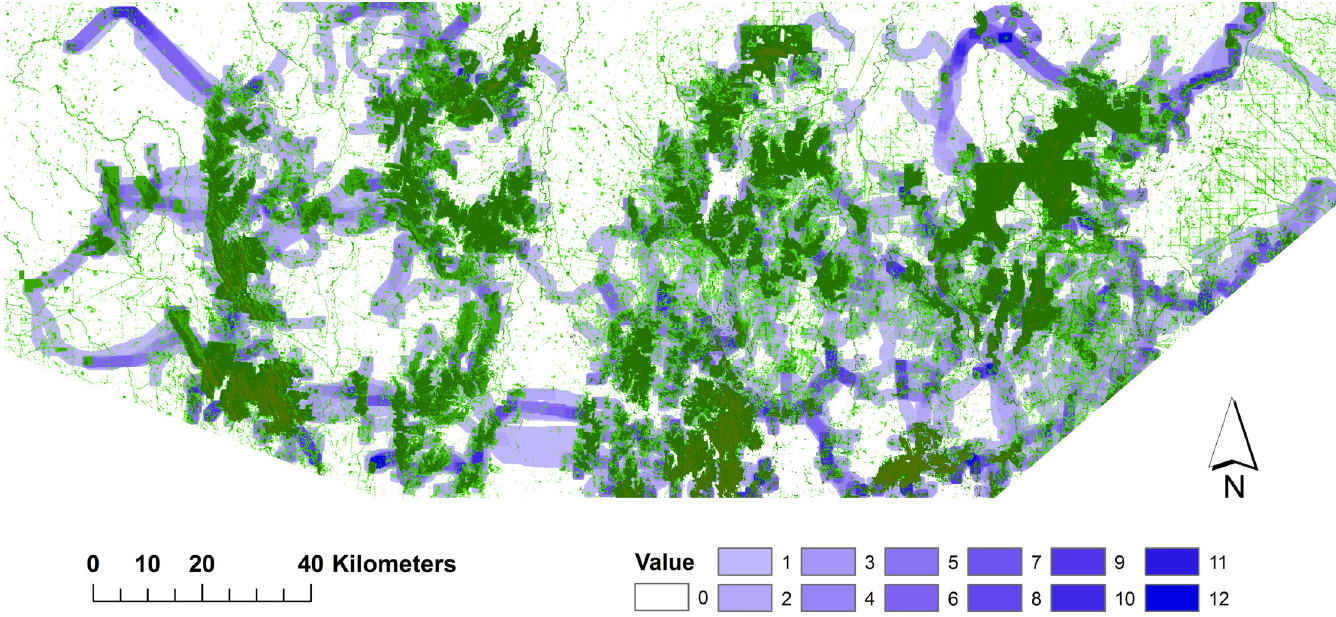
Fig 4. Composite regional connectivity map using resistance surfaces based on species distribution models. It is based on the combined results across all 12 study species. Favoured pathways are shown by darker blue shading, and existing wooded vegetation is in green.